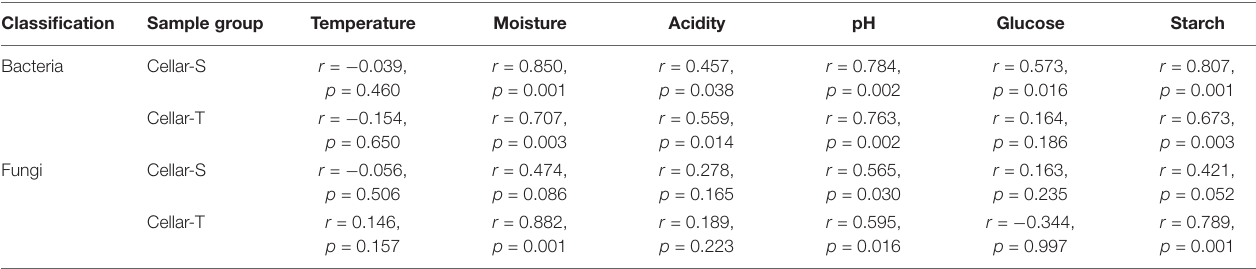
TABLE 3 | Mantel test correlation coefficient ( r ) and p -value for bacterial and fungal communities and measurable environmental variables during the SCSSF (cellar-S) and TCSSF processes (cellar-T). Classification